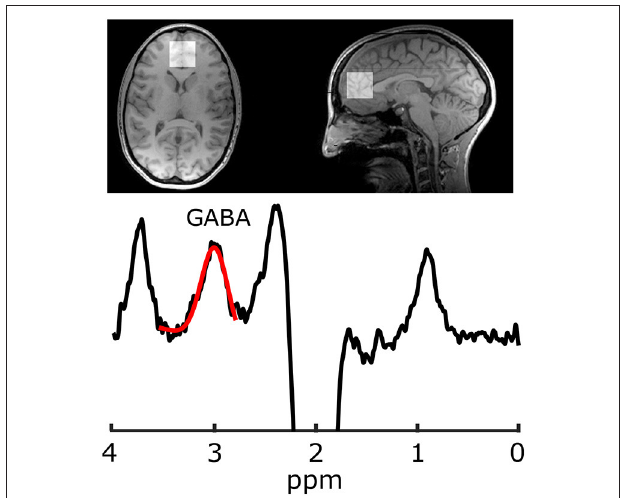
FIGURE 1 | Representative T1 weighted image with mPFC voxel placement and GABA-edited